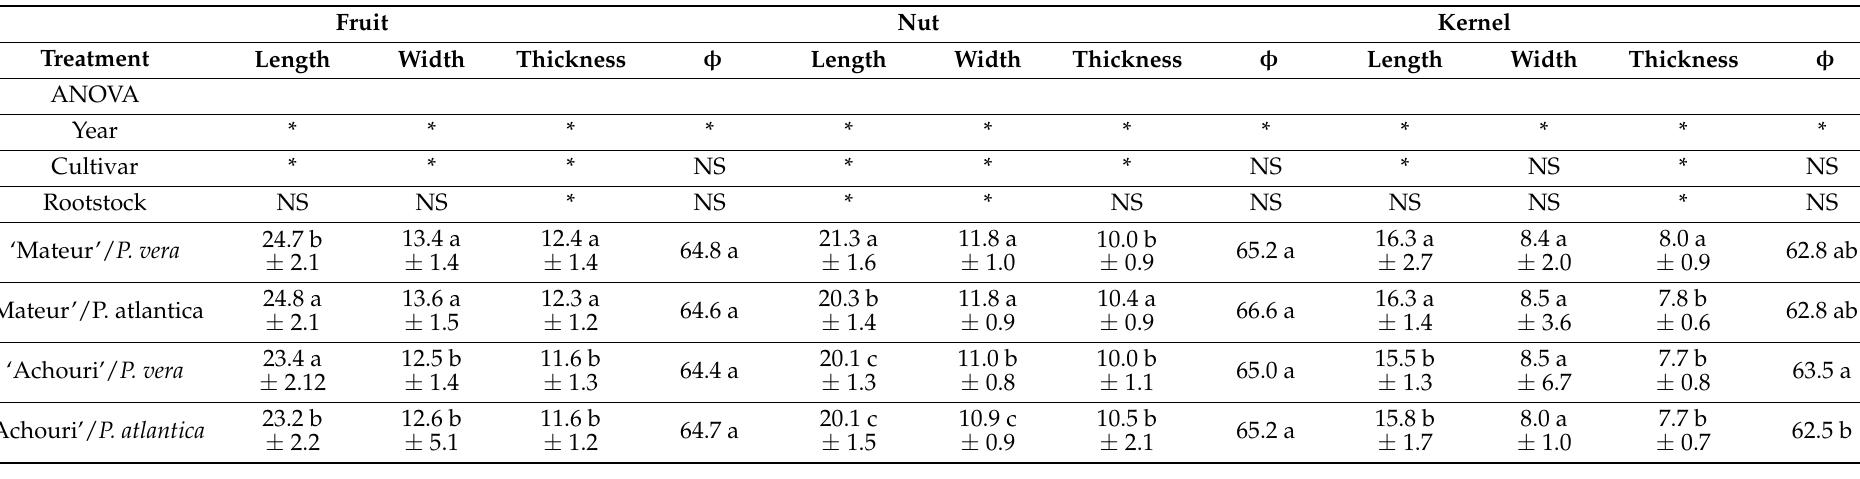
Table 4. Fat content and fatty-acid profile of pistachio kernels.